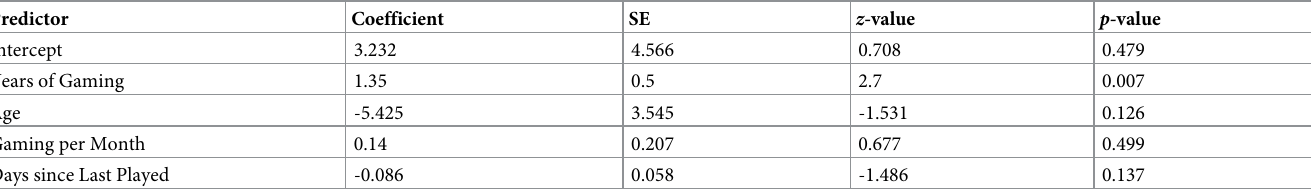
N = 134, 1097 total observations.